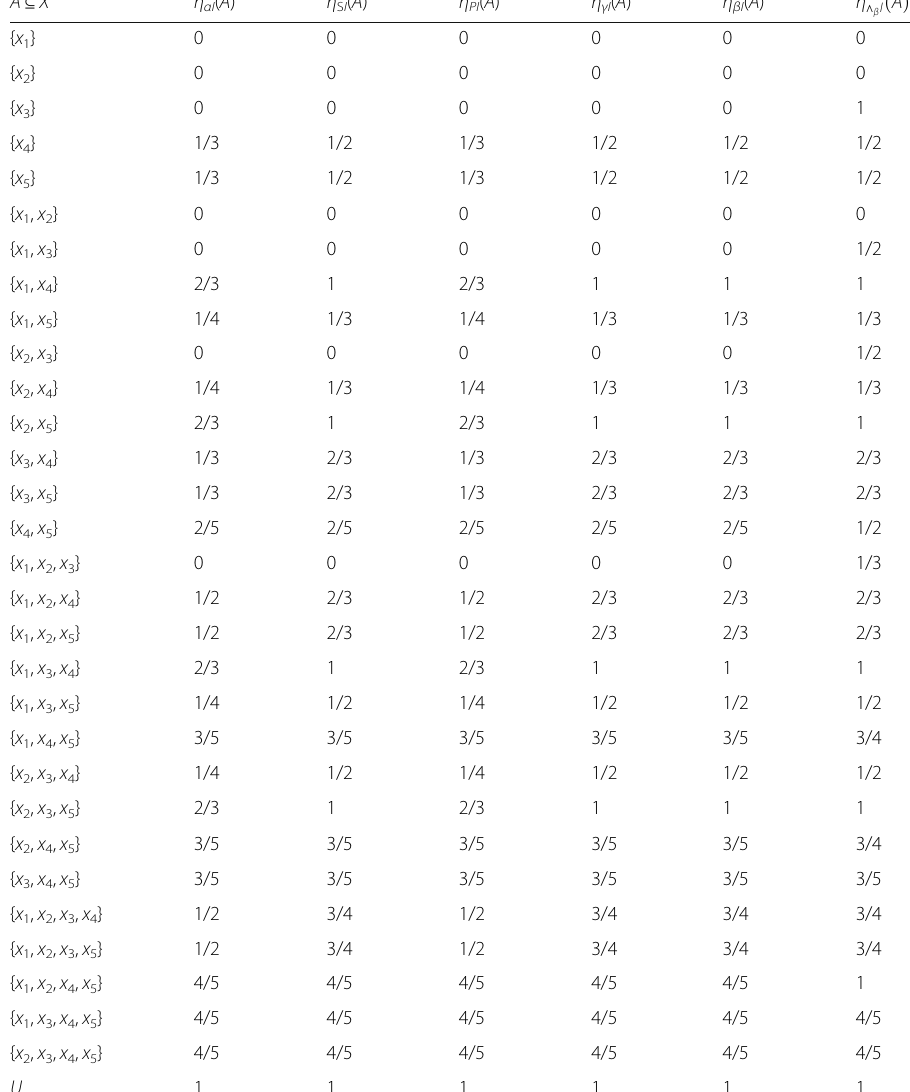
Table 4 Comparison of the j - I -accuracy measures A ⊆